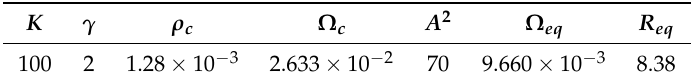
Table 1. Parameters of the fluid model in geometrized units ( c = G = M (cid:12) = 1). The corresponding values in cgs units are reported in the